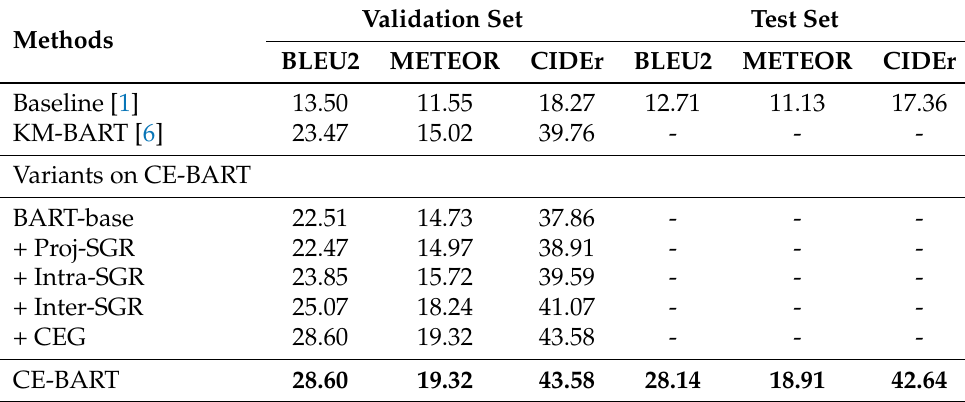
Table 2. Comparison with state-of-the-art methods on the VisualCOMET benchmark. Here, “Proj- SGR” denotes the graph projection (i.e., Equation (1)), “Intra-SGR” denotes the intra-modality reason- ing (i.e., Equation (2)), and “Inter-SGR” stands for the inter-modality reasoning (i.e., Equation (3)). “CEG” stands for the Cause-and-Effect Generator with three decoders (i.e., Equations (9)–(11)). The best results are in